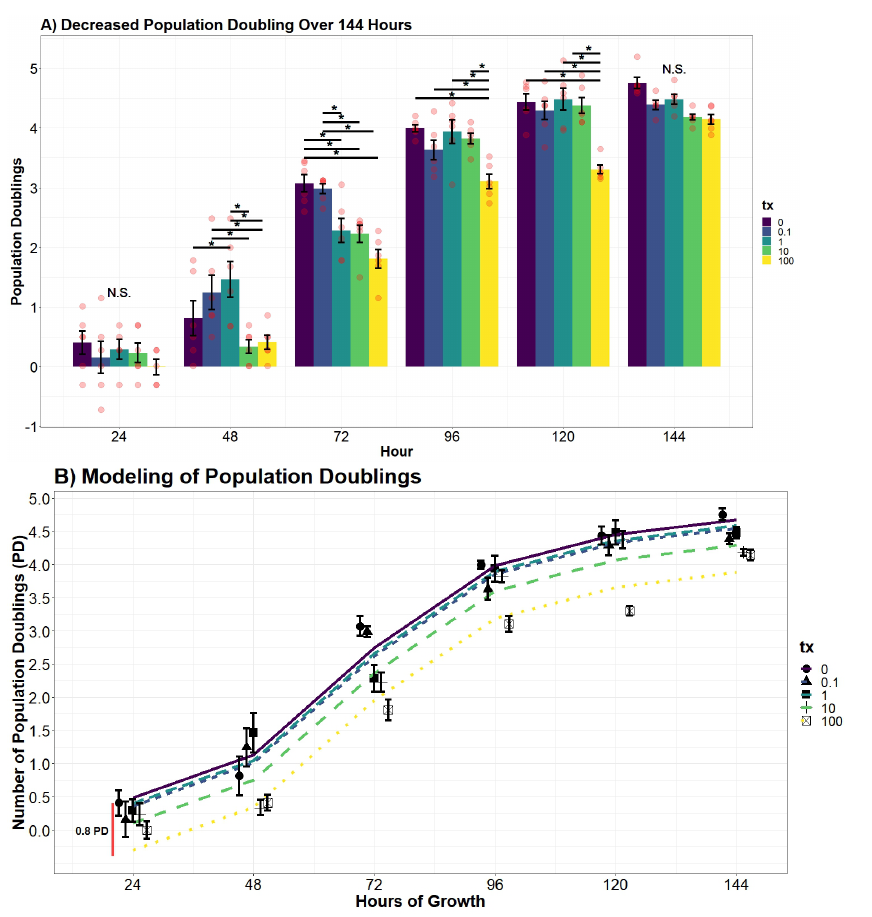
Figure 5. ( A ) Cell population doublings over a 144 h growth curve (n = 6 for each group). Contrasts were performed by a Tukey pairwise t -test across significant variables from an interaction two-way ANOVA. Significance bars, marked with “ * ”, refer to significant Tukey pairwise t -tests between the conditions at the beginning and the end of the bar. Time points where no significant differences were observed are labeled with N.S. ( B ) Polynomial regression modeling of hDFn population doublings (R 2 = 0.9314). Points represent mean PD ± StrErr. Red vertical lines indicates largest PD difference adj observed between control and 100 µ M. Colors of least squares (LS) lines differentiate UN levels.